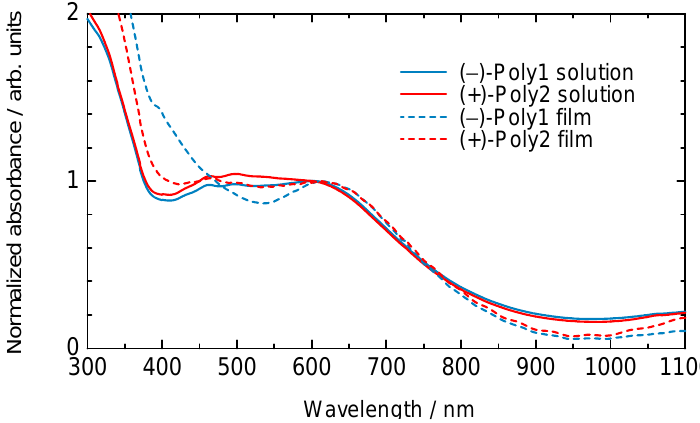
Figure 3. UV-Vis-NIR absorption spectra of (–)-poly1 and (+)-poly2 in solution (0.03 mM in THF) (solid line) and cast films (dashed line).